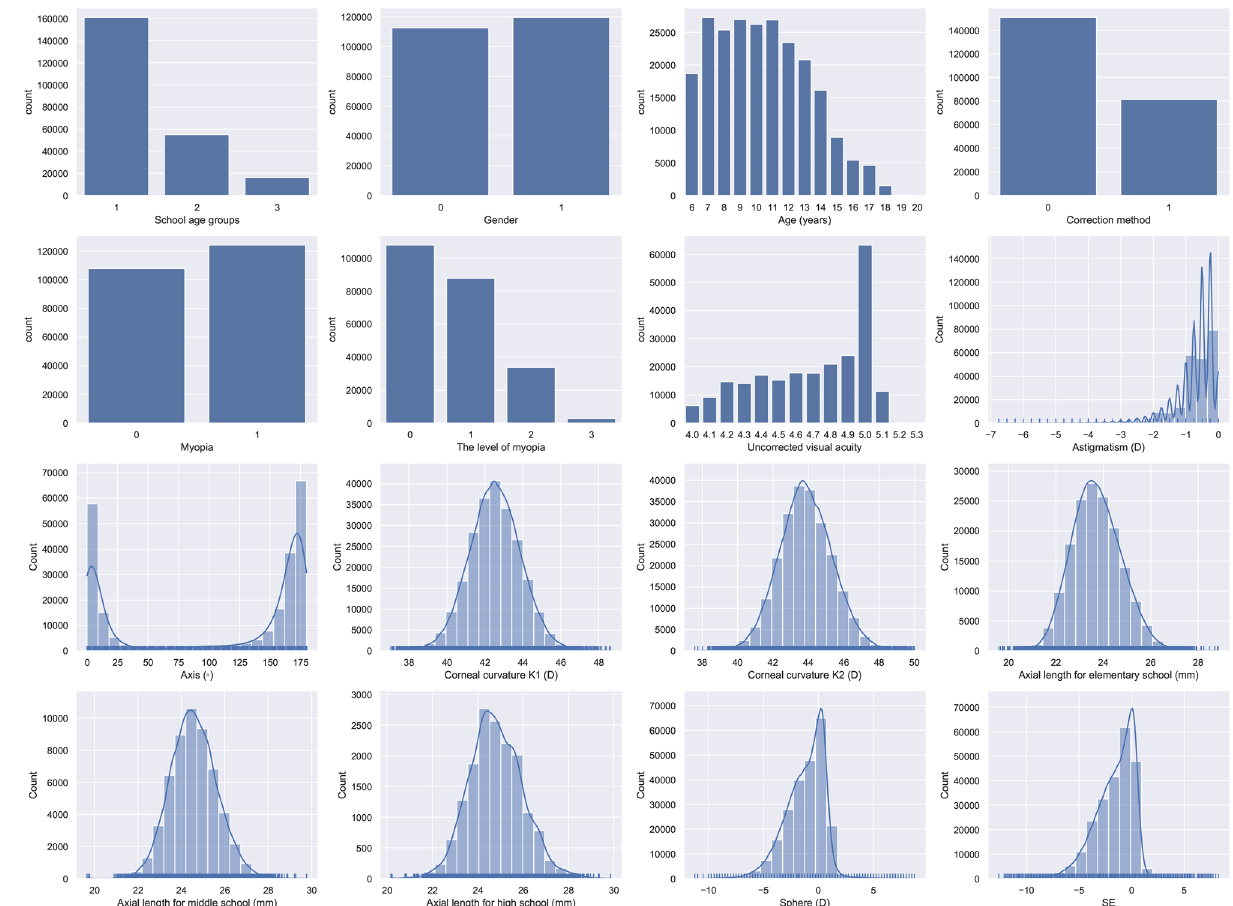
Figure 1. The distributions of features. Particularly, as children and adolescents grow taller over time, the size of eyeballs will gradually elongate, so the overall distribution of axial lengths is divided to three distributions, each corresponds to one age group.